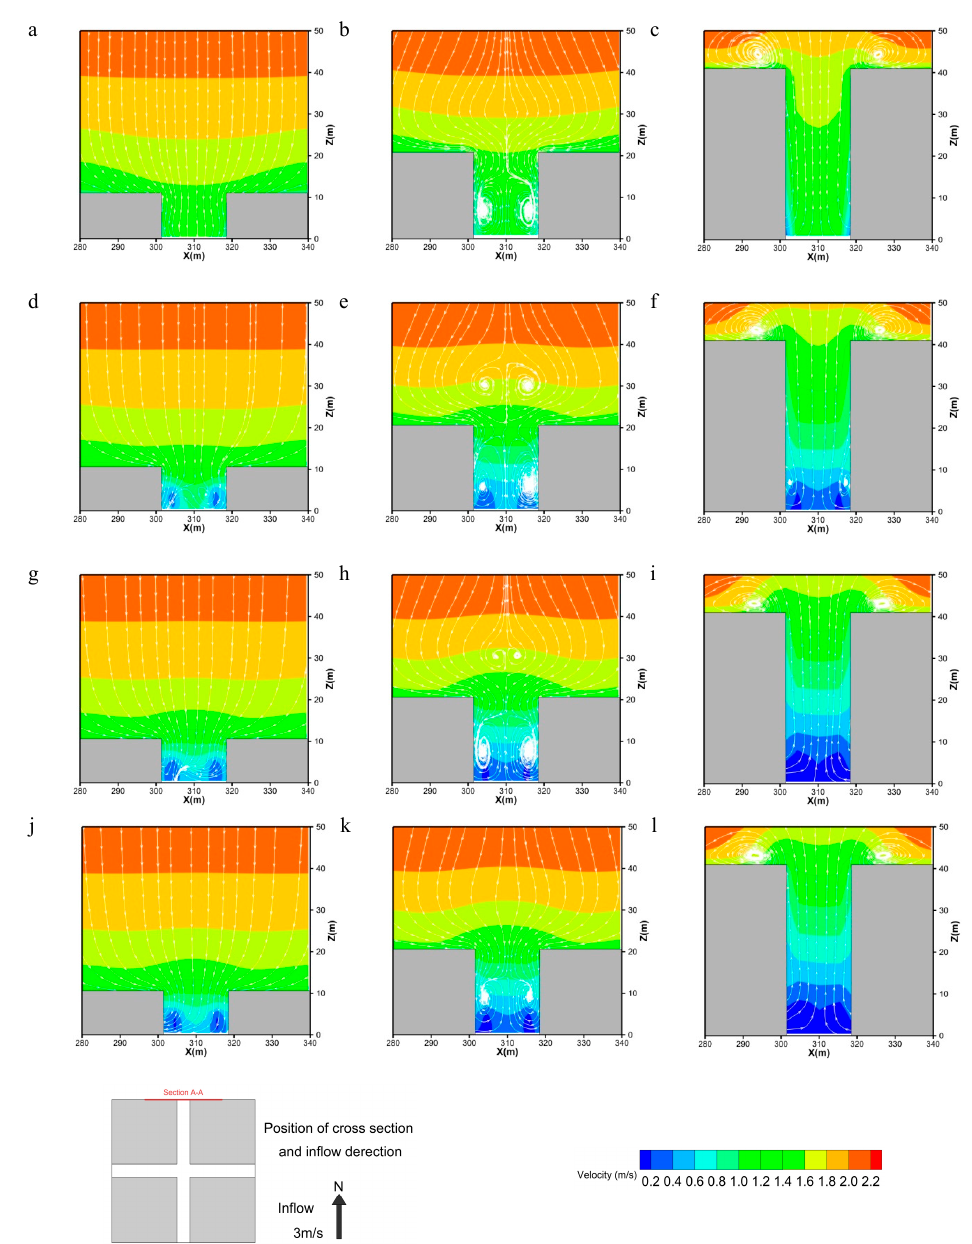
Figure 7. Air velocity and streamline fields at y = 380 m in H/W = 0.5 ( left ), H/W = 1.0 ( middle ), and H/W = 2.0 ( right ) for tree-free scenarios ( a – c ), LAD = 0.5 ( d – f ), LAD = 1.5 ( g – i ), and LAD = 2.5 ( j – l ) with conical canopy.